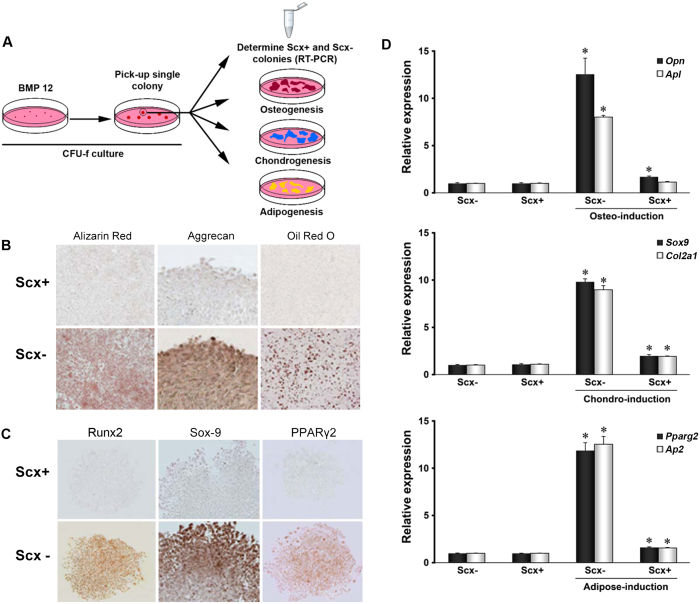
Scleraxis induction is associated with loss of non-tenogenic potential of C3H10T1/2 cells.(A) Schematic procedures of single CFU-F replating assay (SCRA). (B) Cytochemical staining of osteo-(left panel), chondro-(middle panel), and adipo-(right panel) differentiation. (C) Immunohistochemical staining of lineage-specific markers. Data shown in B and C are representatives of three experiments. (D) mRNA expression of lineage-specific marker genes determined by RT-qPCR. Data are expressed as mean ± S.D. (n = 6). *p < 0.01.